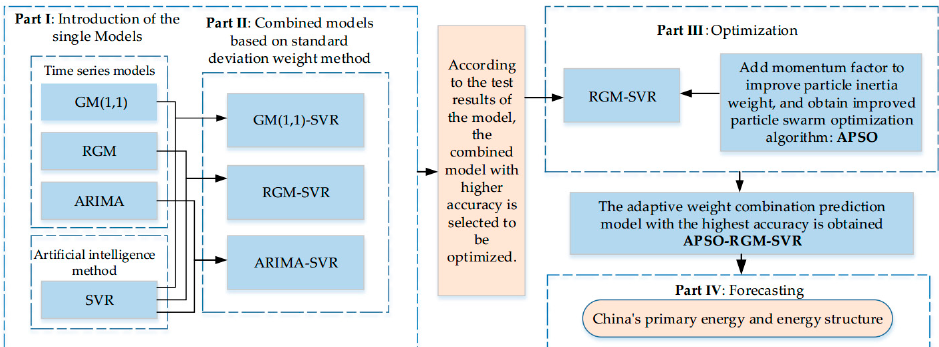
Figure 1. Research framework for forecasting energy demand and energy structure.